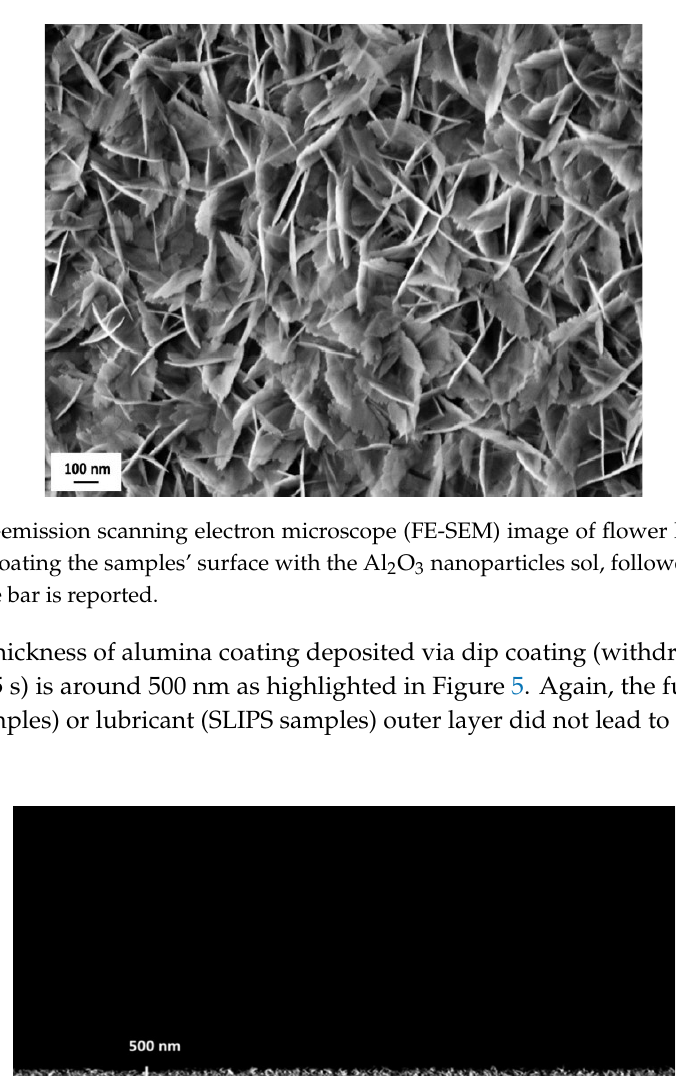
Figure 5. FE-SEM image of the boehmite film thickness. Scale bars are reported.